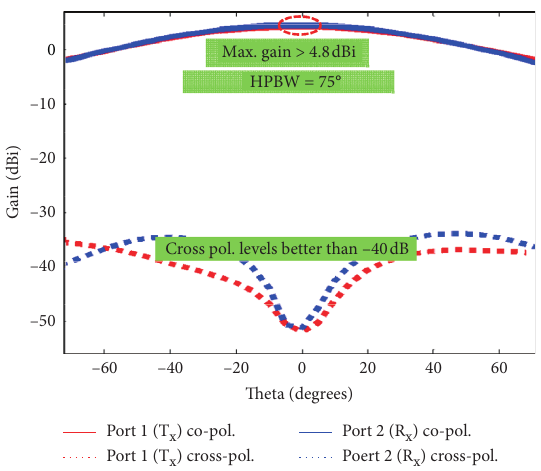
Figure 8: The measured T polarization gain levels for the presented antenna at 2.405GHz